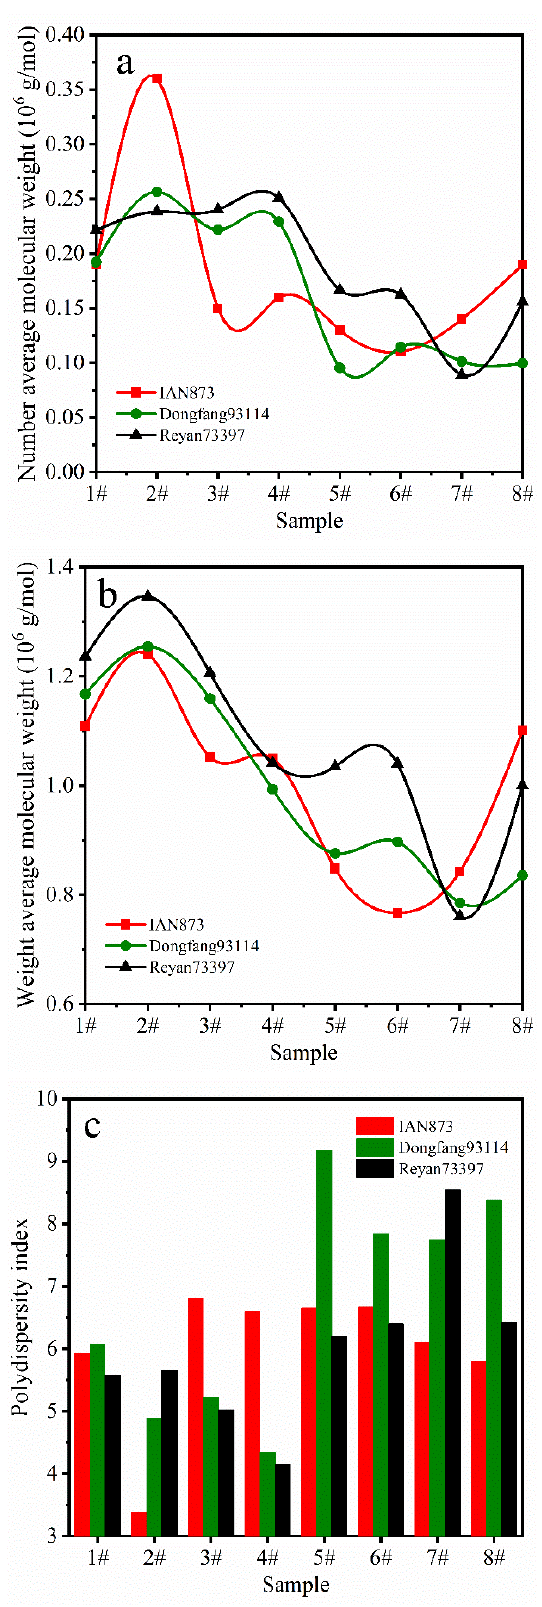
– – – – —— —— M n , ( b ) M w , ( c ) PDI and particle sizes of n , ( b ) M w , ( c ) PDI and particle sizes of rubbers.